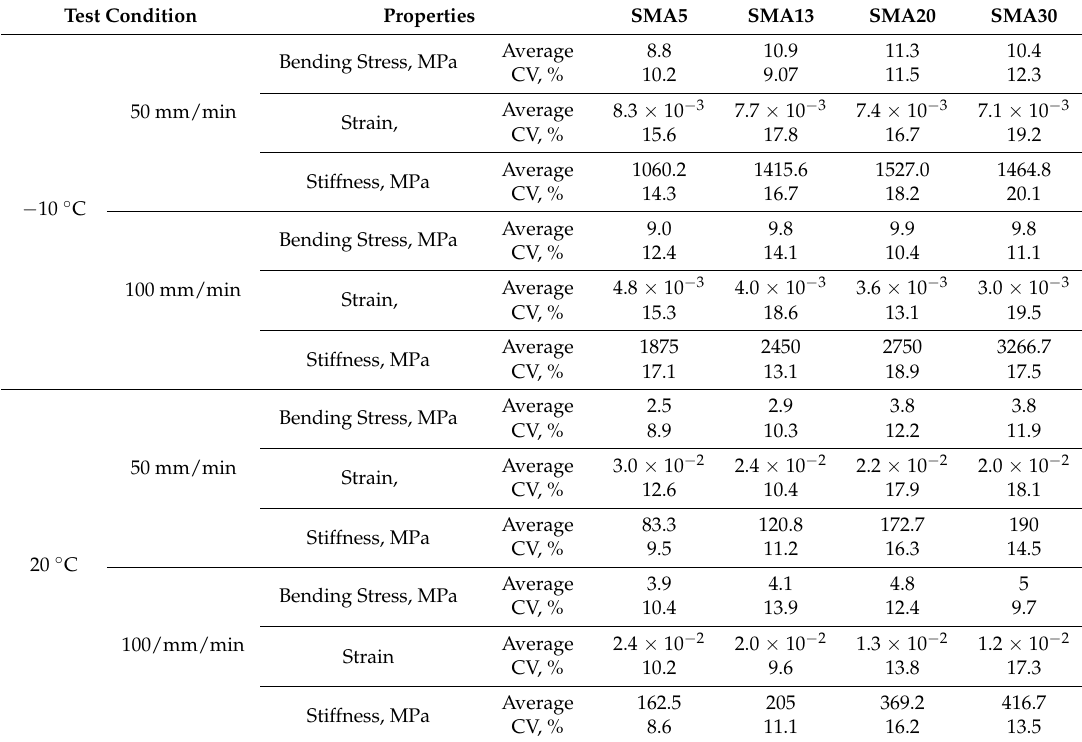
Table 8. Results of three-point bending